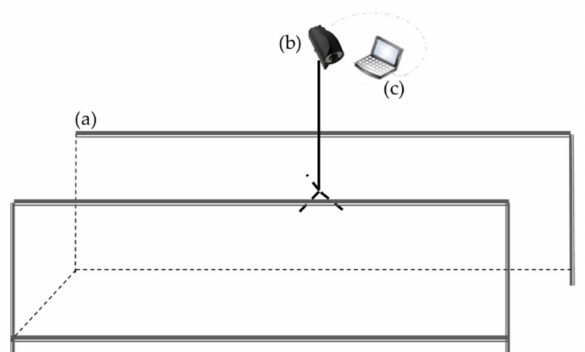
Figure 1. Top view of the cow lameness detection system based on a 2D camera: ( a ) the passing alley, ( b ) the 2D camera and ( c ) a computer or industrial